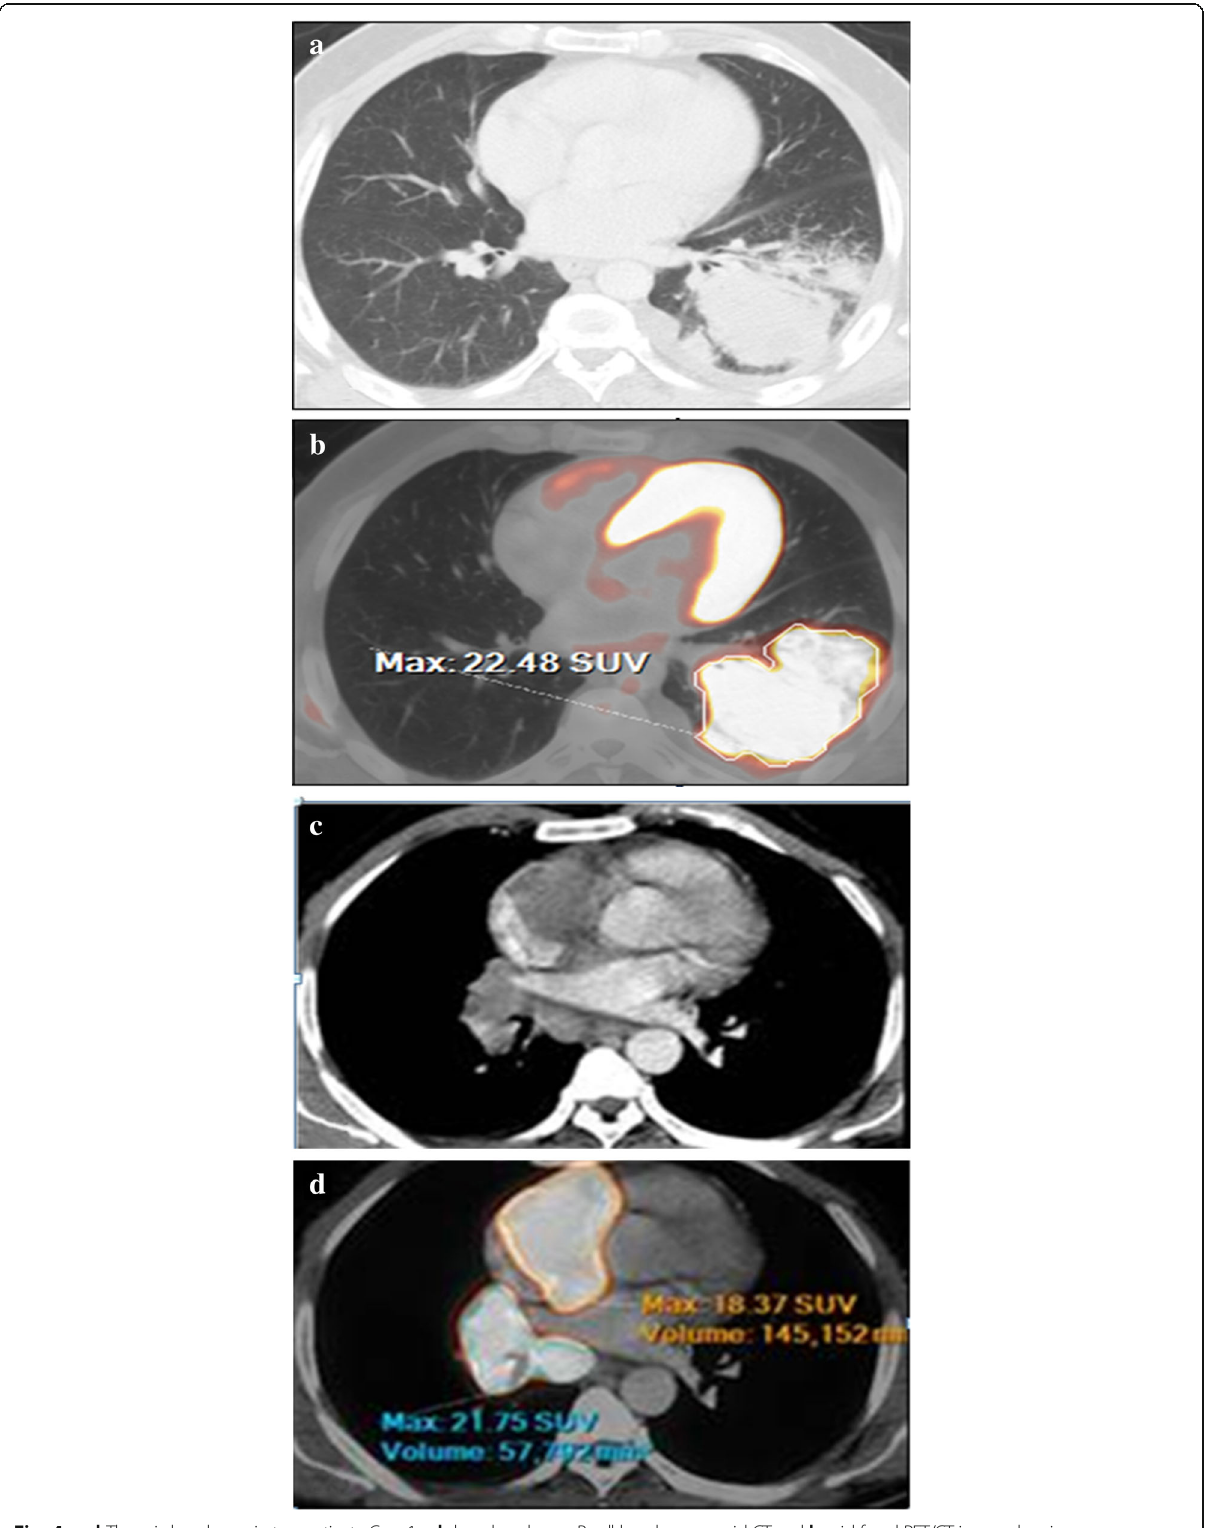
Fig. 4 a – d Thoracic lymphoma in two patients. Case 1 a , b lung lymphoma, B cell lymphoma a axial CT and b axial fused PET/CT image, showing a hypermetabolic lesion at the left lower lung lobe. Case 2 c , d cardiac lymphoma, DLBCL type c axial CT showing a large hypodense soft tissue mass within the right atrium presumed to be intra-atrial thrombus. In the axial fused PET/CT ( d ), it is intensely avid associated with subcarinal and right hilar avid